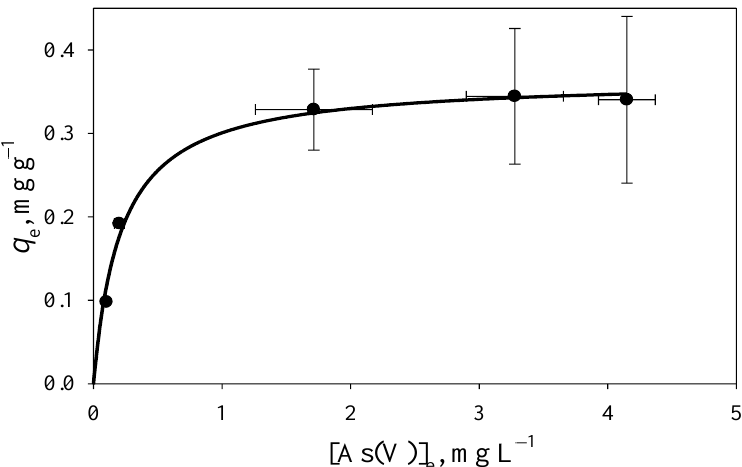
Figure 5. Adsorption equilibrium of As(V) on the clay. Conditions: [As(V)] = 5 mg L − 1 , pH 7, [clay] = 2.5–50 g L − 1 , RT, EC = 0.03 mS cm − 1 . Error bars represent the standard deviation between duplicates, while the full line is the adjustment to Equation (5).